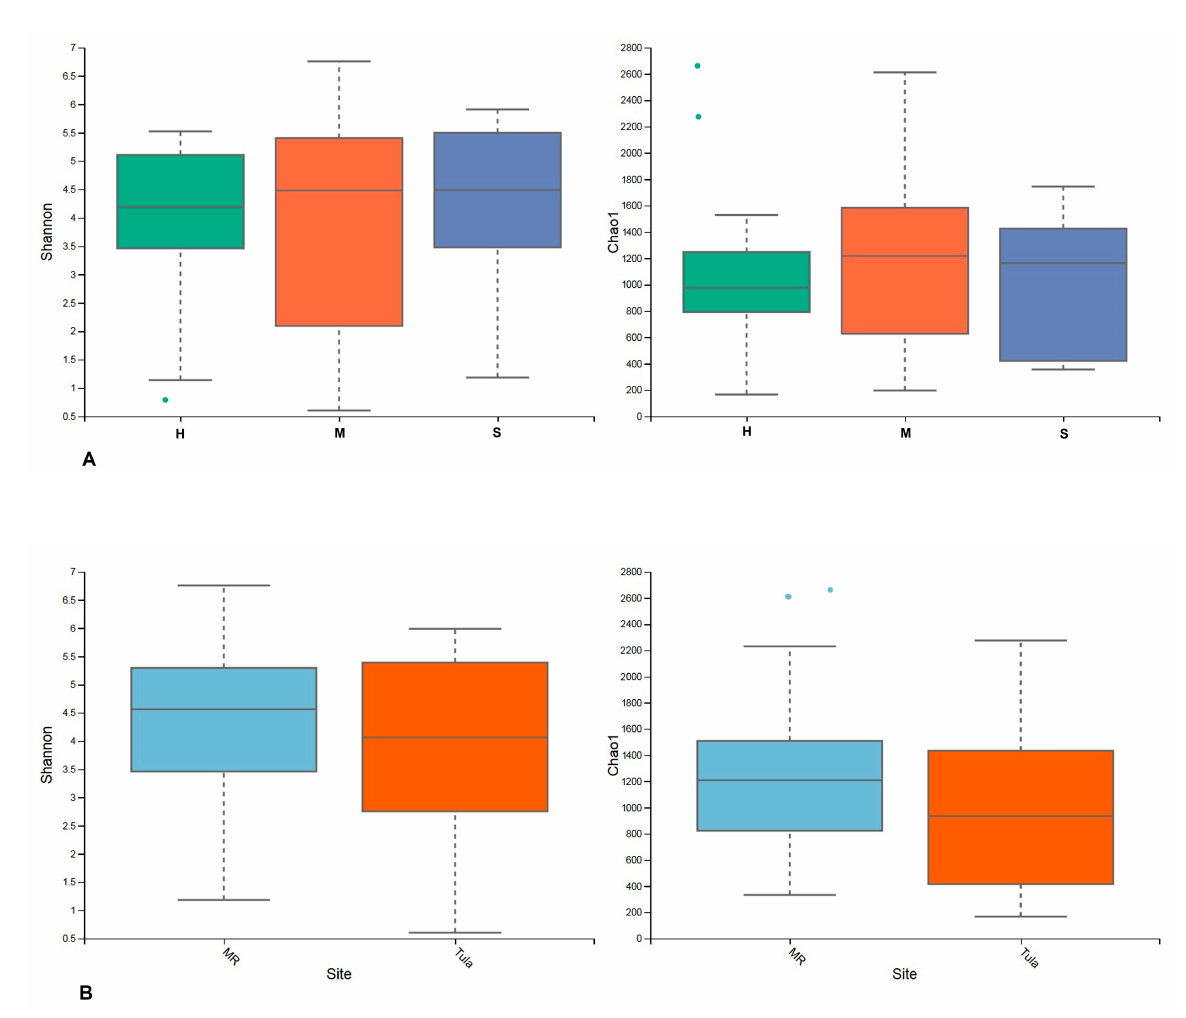
Figure 3. Diversity and evenness. ( A ) Shannon and Chao1 indices for all three groups (H, M, S). ( B ) Shannon and Chao1 indices for both sites (MR—Moscow region, Tula—Tula region).